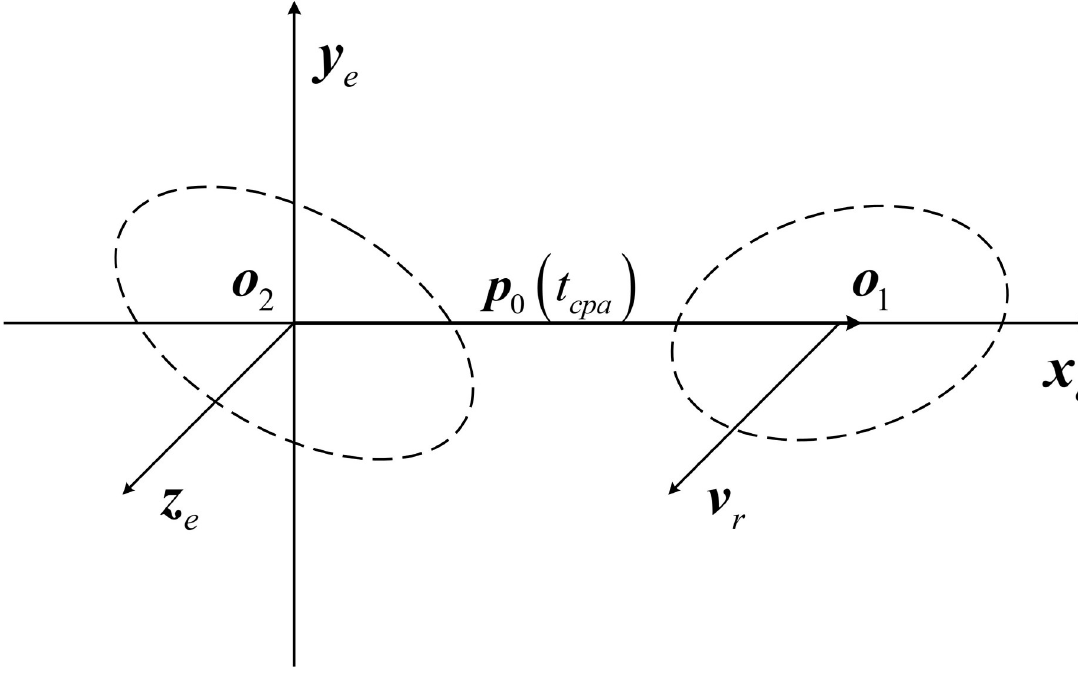
Fig 5. Encounter coordinate